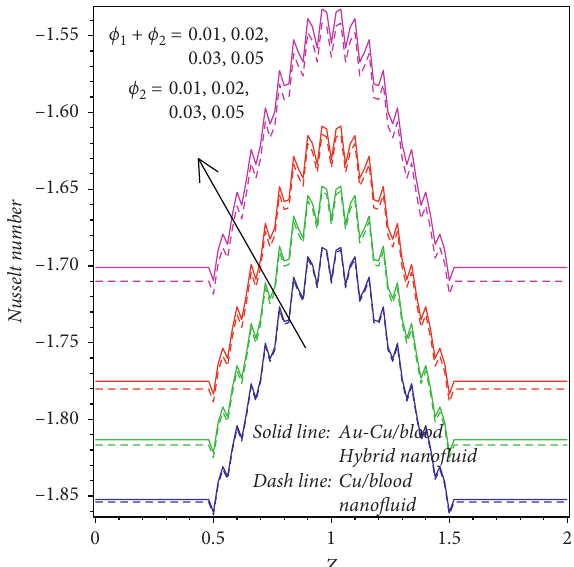
Figure 26: Behaviour of ϕ